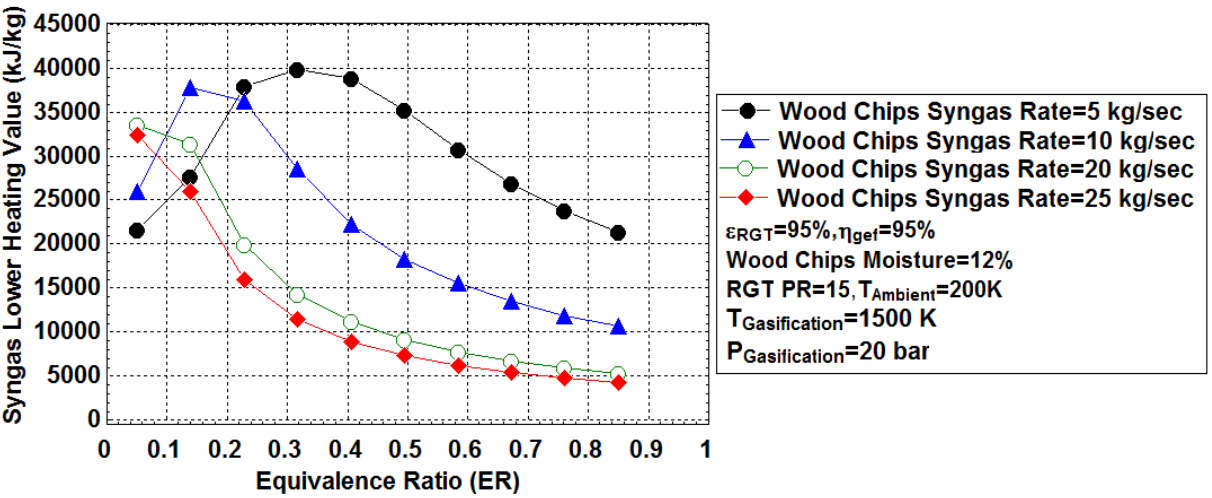
Figure 4. Equivalence ratio versus syngas lower heating value at different Wood Chip syngas rates.